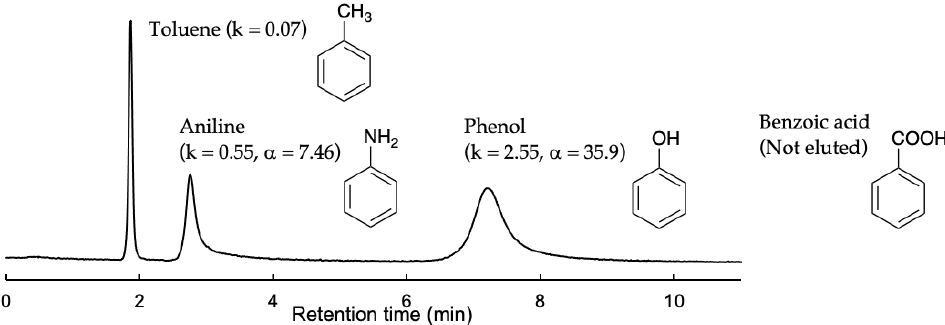
Figure 7. Chromatogram of toluene, aniline, phenol, and benzoic acid using Sil − VP G 15 . Mobile phase: Acetonitrile. Flow rate: 1.0 mL min −1 . Temperature: 25 °C.